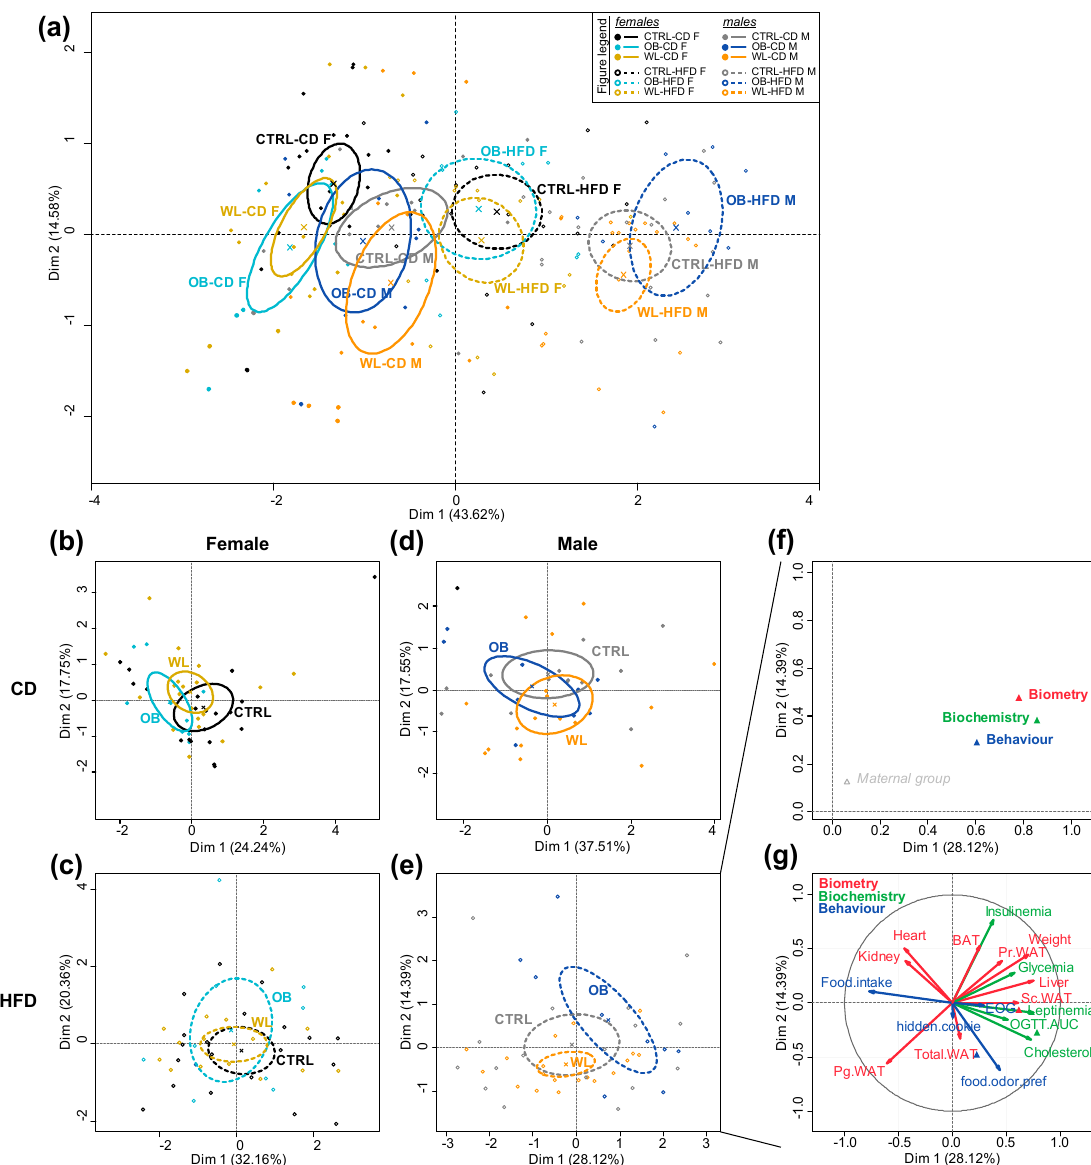
Figure 7. Multiple factor analysis (MFA) reveals an influence of maternal group on HFD-fed males. “Biometry”, ”Biochemistry” and “Behaviour” data from females and males were analysed by MFA. Plot ellipses with their barycentre for maternal group are represented on the two first dimensions of the MFA for all the offspring ( a ), females ( b, c ) and males ( d, e ) and according to post-weaning diet CD ( b, d ) or HFD ( c, e ). Correlation ( r 2 ) of the variables groups to the two dimensions of the MFA is represented on the categories correlation graph ( f ) and correlation ( r ) of the variables to the two dimensions of the MFA on the variables factors map ( g ) for HFD-fed males.